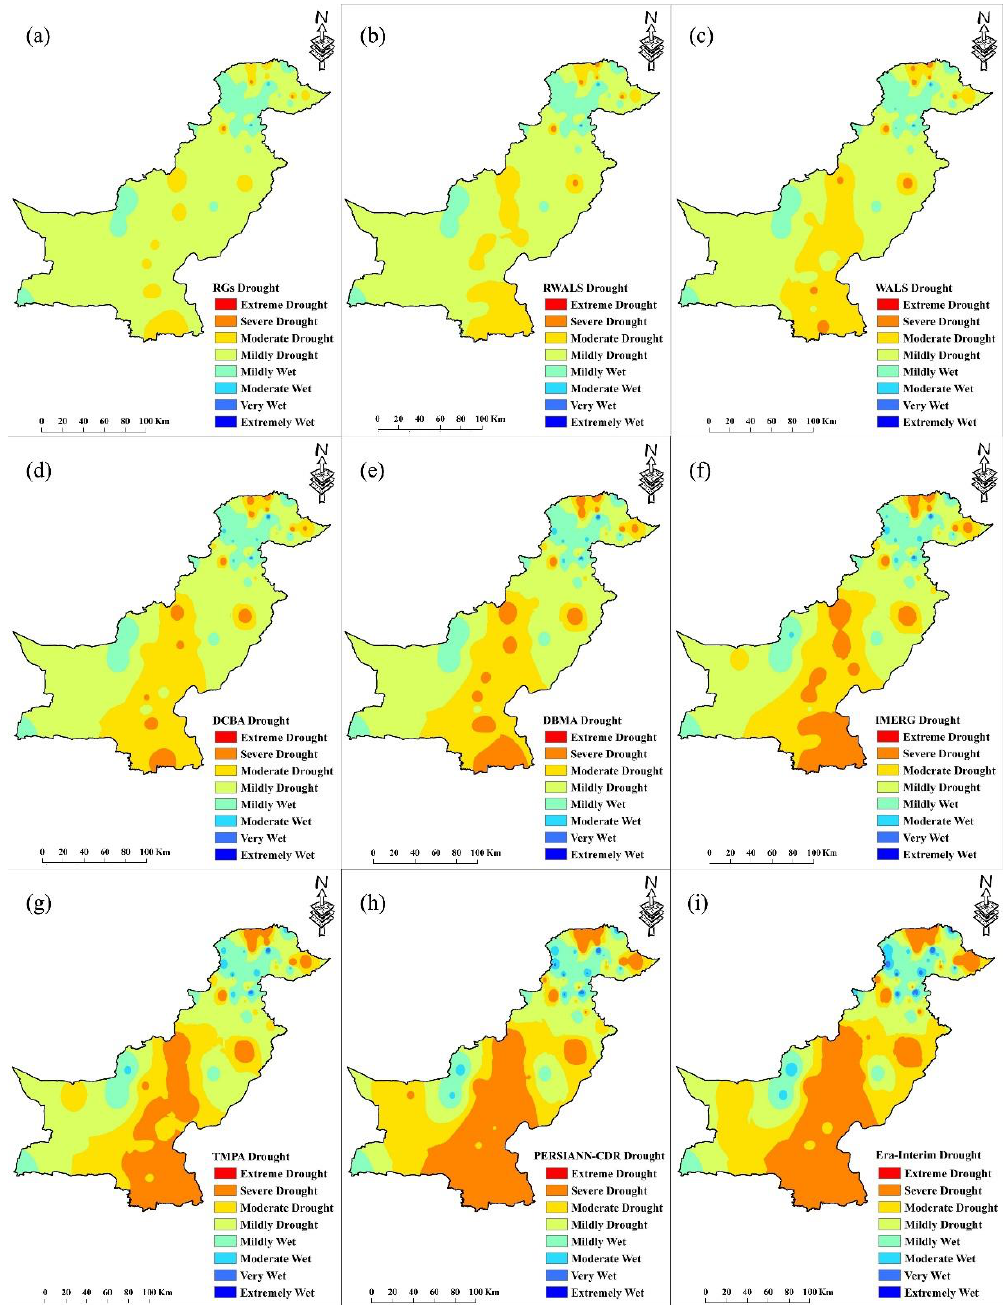
Figure 5. Spatial distribution drought (SPI-3) across Pakistan during pre-monsoon season in the representative drought year (2008), ( a ) RGs, ( b ) RWALS-MSPD, ( c ) WALS-MSPD, ( d ) DCBA-MSPD, ( e ) DBMA-MSPD, ( f ) IMERG, ( g ) TMPA, ( h ) PERSIANN-CDR, and ( i ) ERA-Interim.